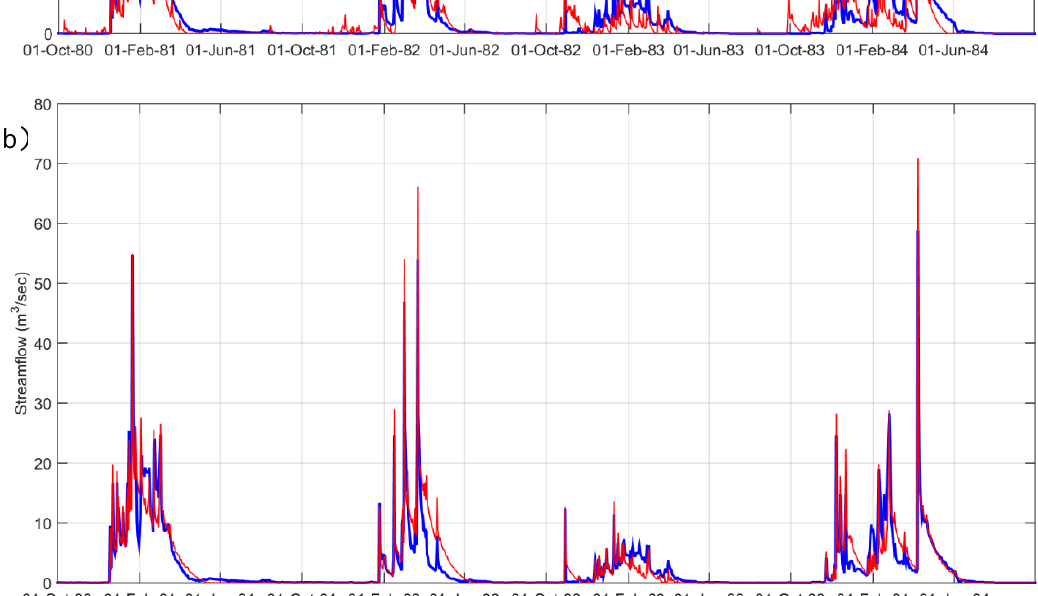
Figure 5. Observed versus modeled streamflow for the calibration period, by using as model input ( a ) e ff ective rainfall generated from climate data, or ( b ) e ff ective rainfall generated from observed